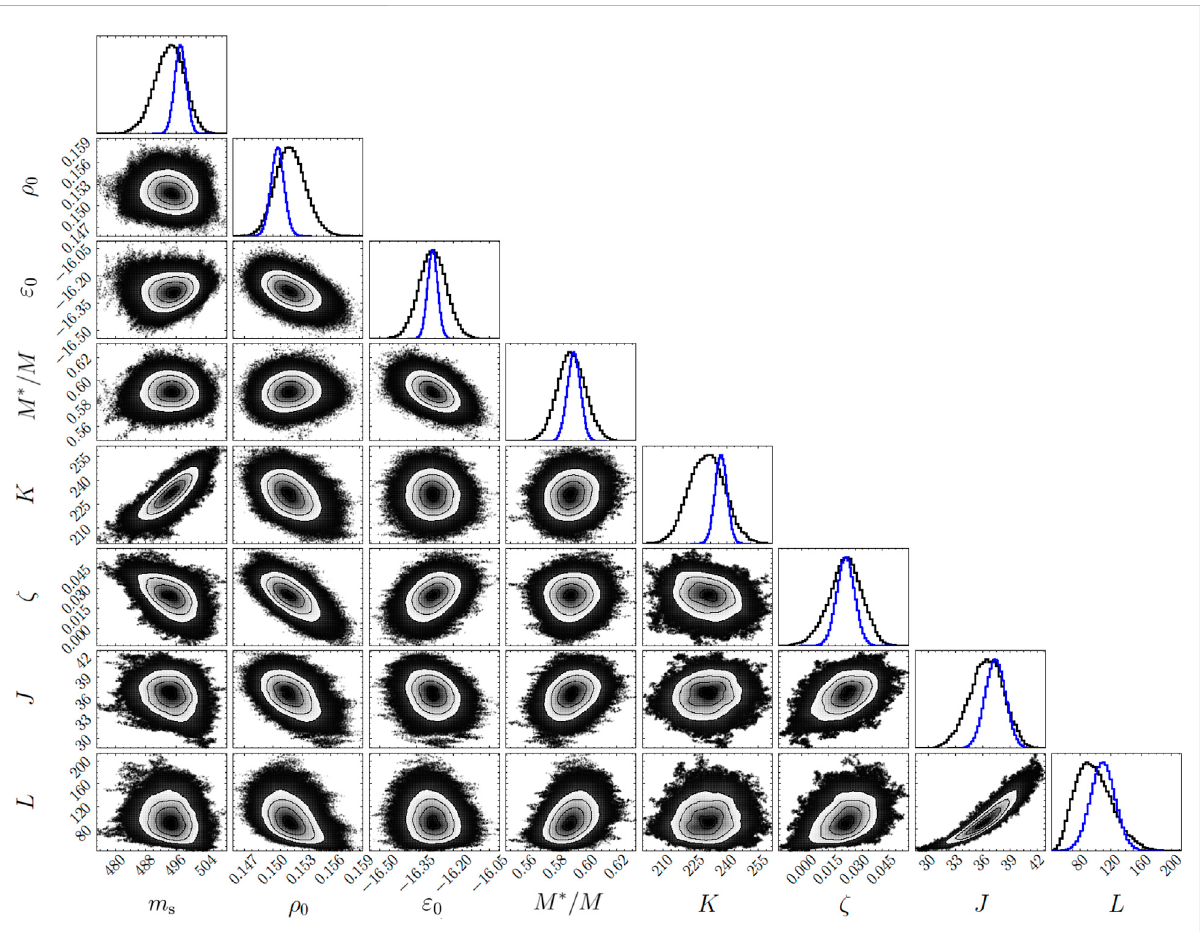
FIGURE 5 Corner plot [81] from the posterior distribution of the eight bulk matter parameters θ obtained from the Metropolis-Hasting sampling with surmise . A total of fi ve million samples were used, distributed along eight independent chains. The saturation density ρ massofthe σ meson m s ,thebindingenergyatsaturation ε 0 ,theincompressibilitycoef fi cient K ,thesymmetryenergy J anditsslope L atsaturationare allexpressedinMeV.Forcomparison,theoriginalcalibrationdonein[60]isshownasthebluecurvesalongthediagonal,scaledverticallyto fi tin the same plot as our posterior results in